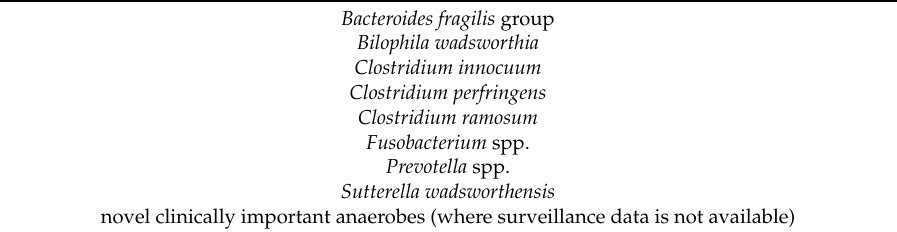
Table 4. List of anaerobic bacteria where routine susceptibility testing is recommended [23].